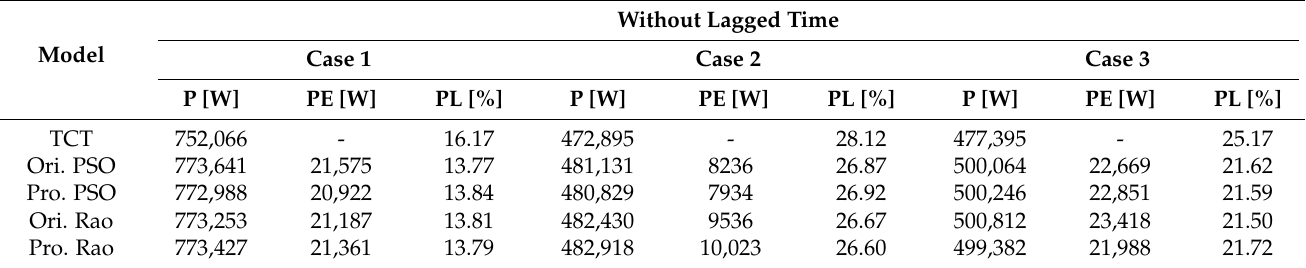
Table 4 indicates the total number of switching times of the PV array with the original and proposed DPVAR models. In general, the proposed DPVAR models require